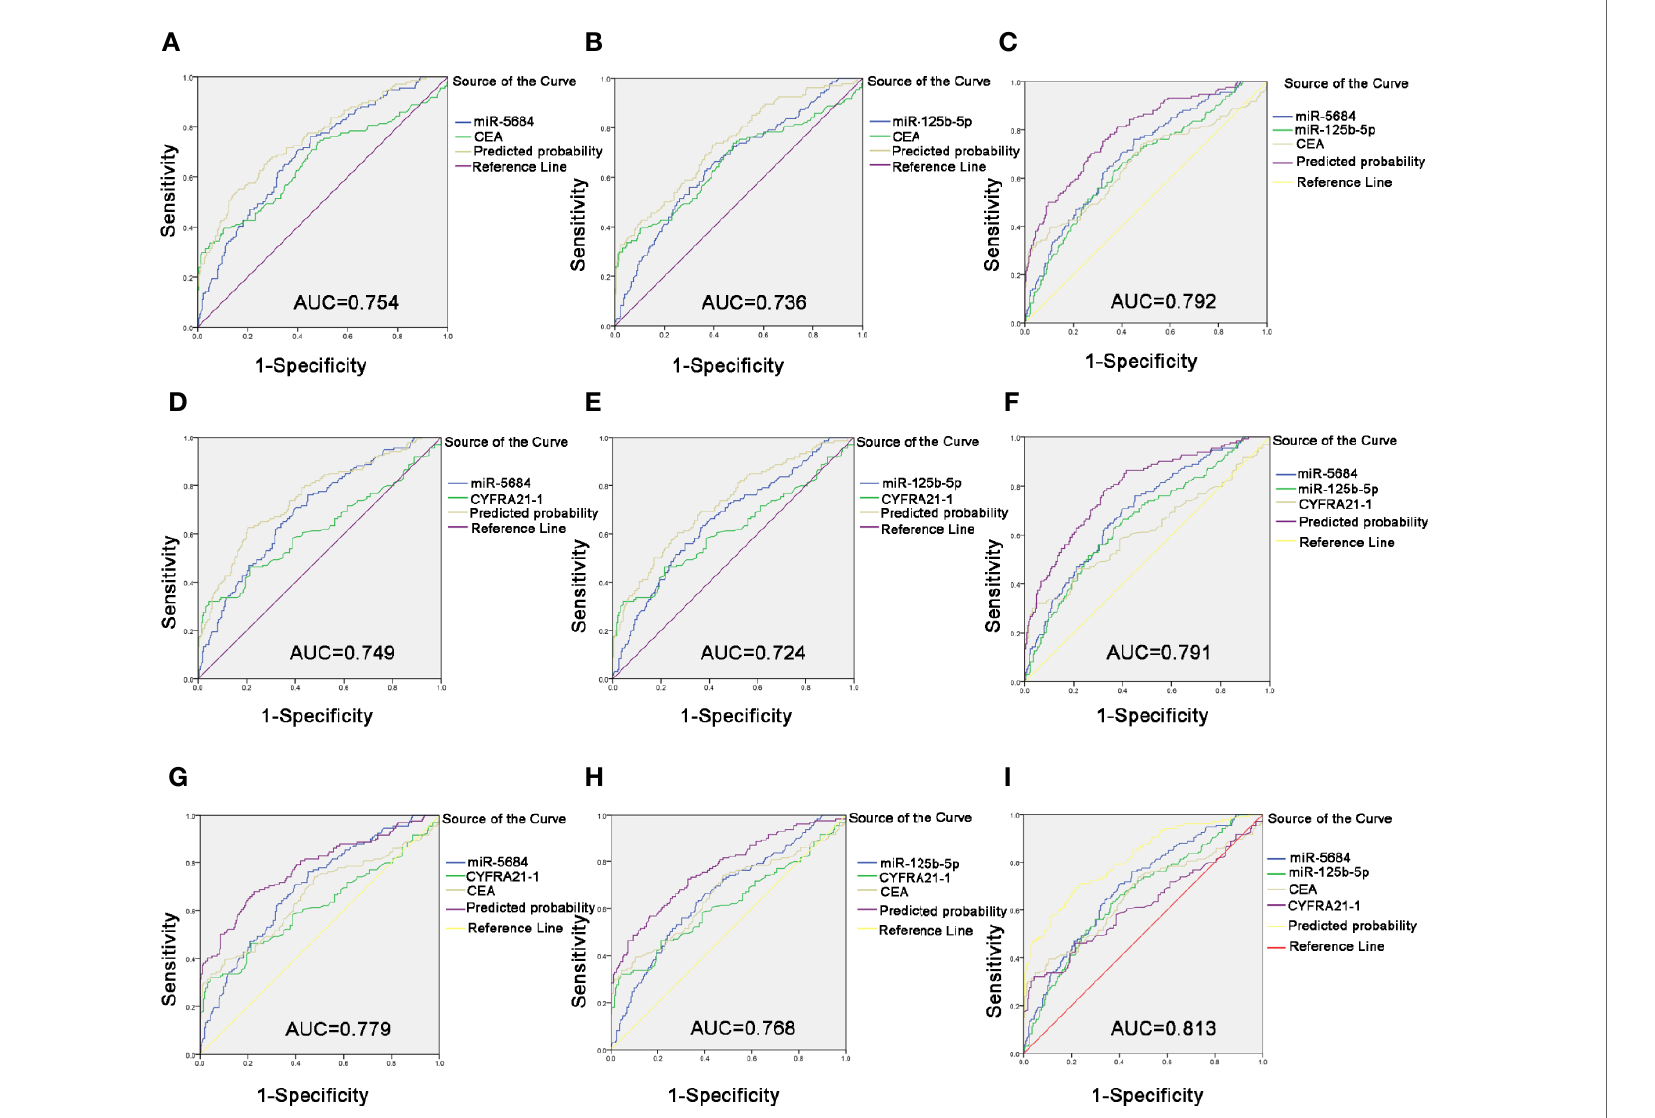
FIGURE 7 | Improved diagnostic capacity of serum exosomal miRNAs combined with established tumor markers in early-stage NSCLC patients. The AUCs of CEA combined with miR-5684 (A) , miR-125b-5p (B) , and both (C) . The AUCs of CYFRA21-1 combined with miR-5684 (D) , miR-125b-5p (E) , and both (F) . The AUCs of CEA and CYFRA21-1 combined with miR-5684 (G) , miR-125b-5p (H) , and both (I)